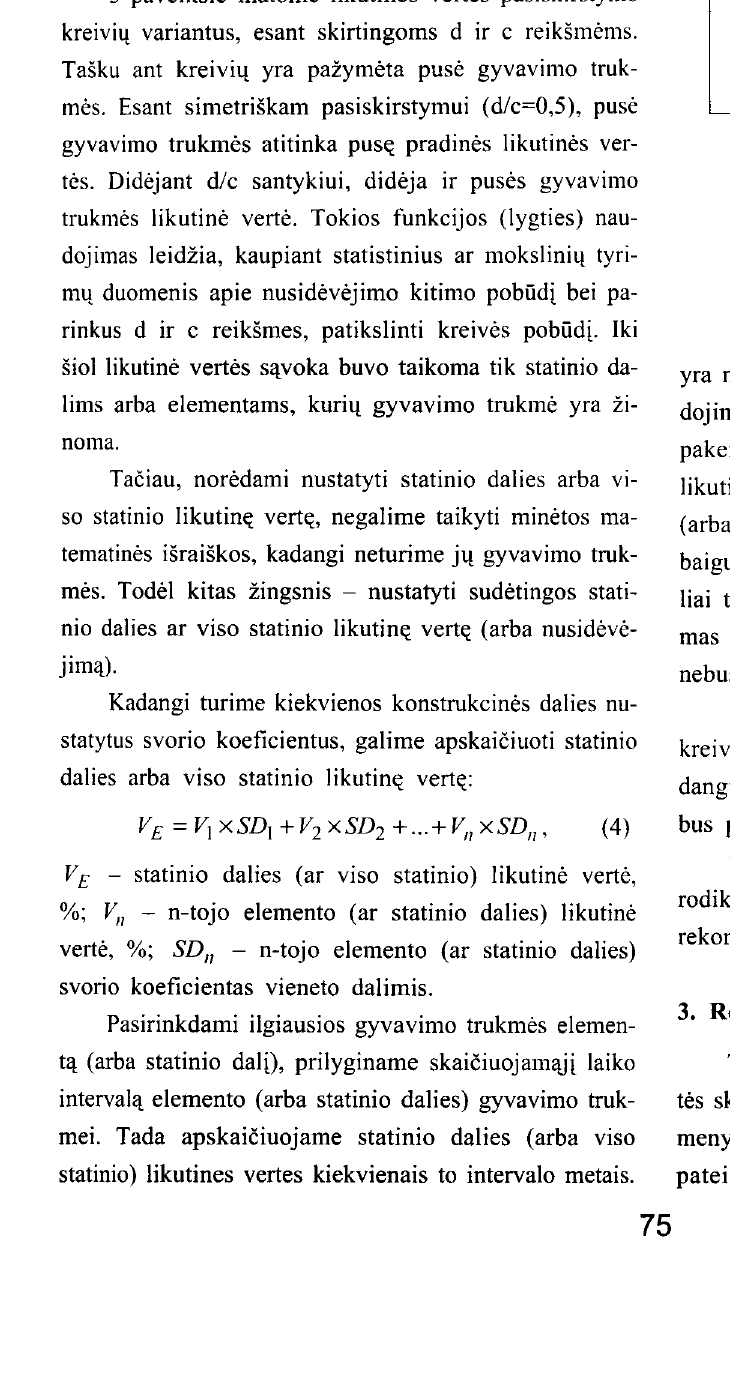
Fig 3. Building construction (element) depreciable val ues function throughout its life cycle